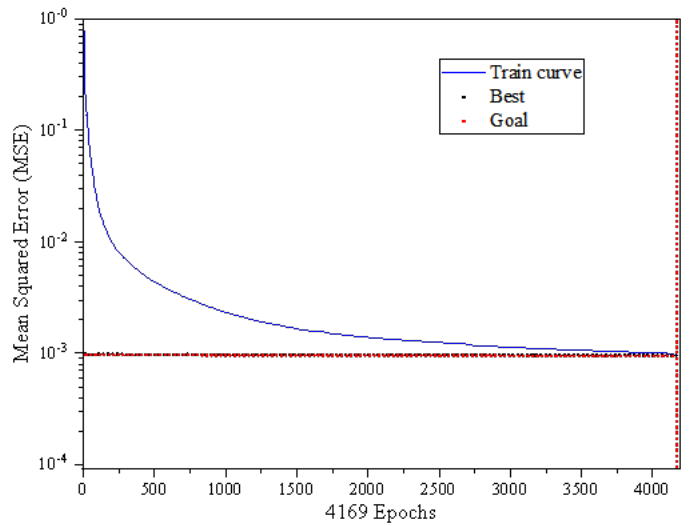
Figure 11. Fitting line of the copper recovery predicted by the BP neural network model.